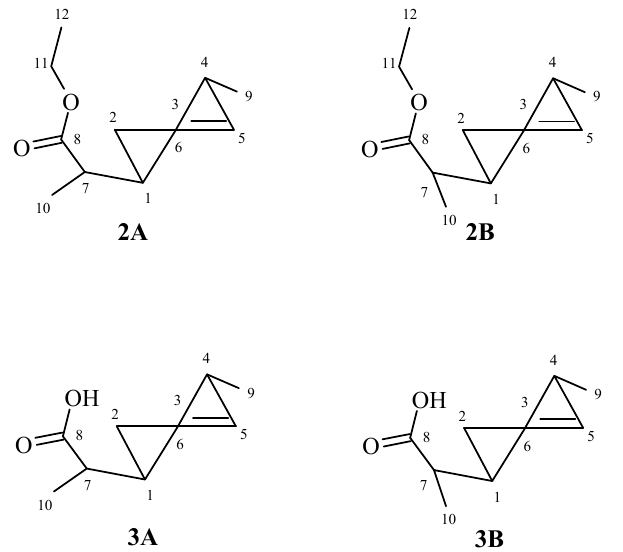
Figure 1. Synthesis of (±)-halolactones 4 – 6. The analysis of 1 H NMR spectra of both isomers A and B of ester 2 and acid 3 showed that in both cases, the methyl group located at C-5 carbon took an equatorial position. This was indicated by the signals from H-5 protons of both A and B isomers, being wide multiplets in the range of 2.45–2.58 ppm (ester 2 ) and 2.53–2.63 ppm (acid 3 ). The side chain also occupied an equatorial position, as evidenced by wide multiplets in the range 1.97–2.06 and 1.99–2.09 ppm derived from H-1 protons of both isomers A and B ester 2 and acid 3 , respectively (Figure 2).